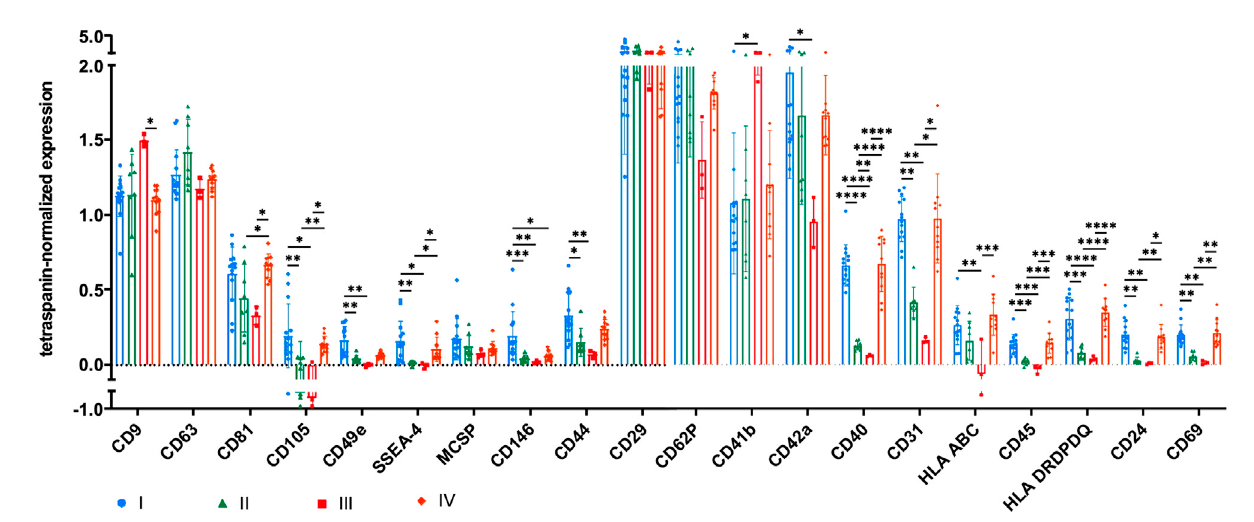
Tetraspanin-normalized surface antigen expression by sEVs. Surface antigen expression of sEVs isolated by methods I (blue), II (green), III (red) and IV (orange) was analyzed using MACSPlex technology. sEVs were bound by capture beads with epitopes against each analyzed surface antigen and detected indirectly byanAPC-coupled detection reagentdirectedagainstthetetraspaninsCD9,CD63, andCD81.Due totheindirectdetection, fl uorescence intensity of each surface antigen was normalized on mean fl uorescence intensity of CD9, CD63, and CD81, resulting in tetraspanin-normalized expression. Data are presented as mean ± SD, and N ≥ 3 independent experiments were performed. Statistically signi fi cant differences are depicted as follows: *: p < 0.05, **: p < 0.01, ***: p < 0.001, ****: p <